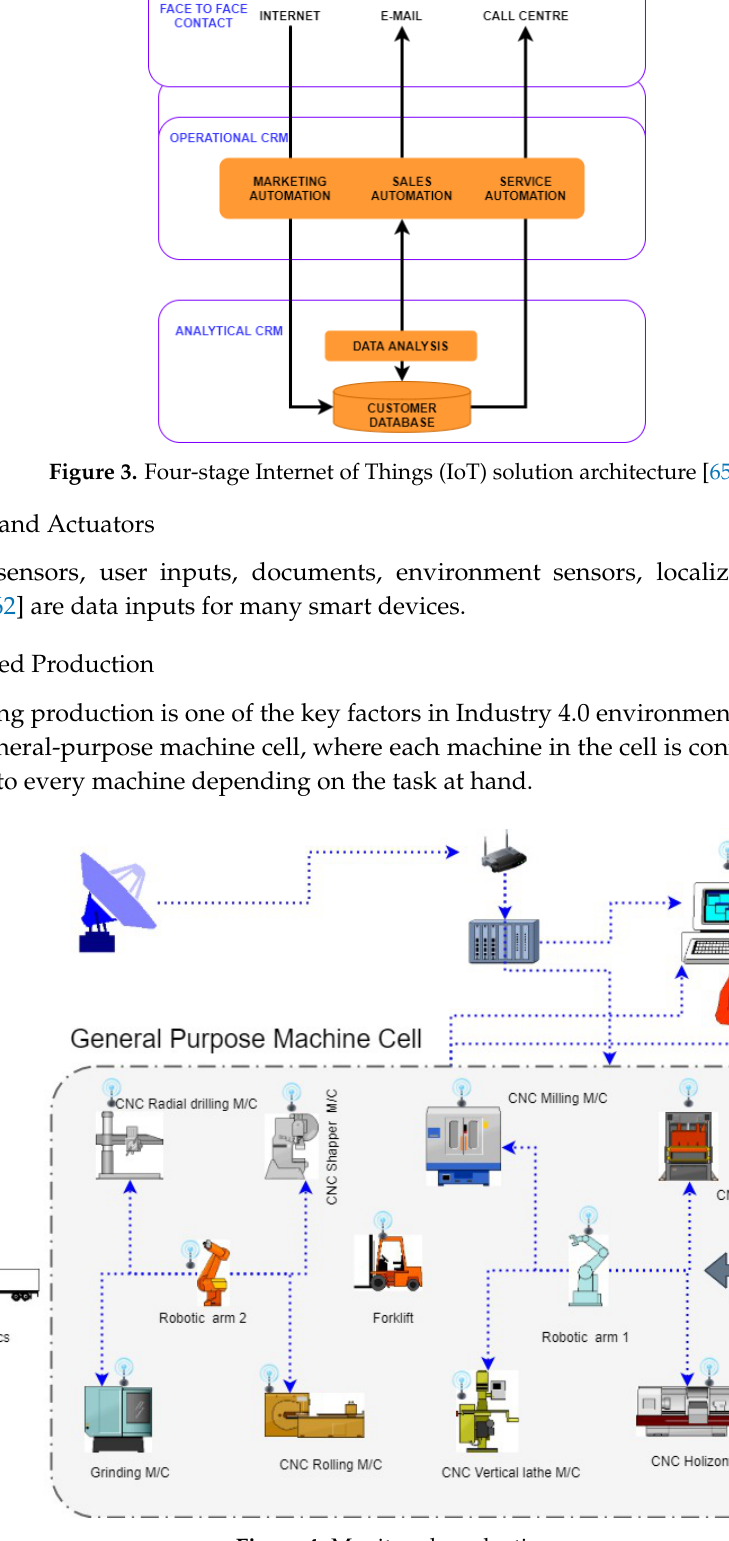
Figure 4. Monitored